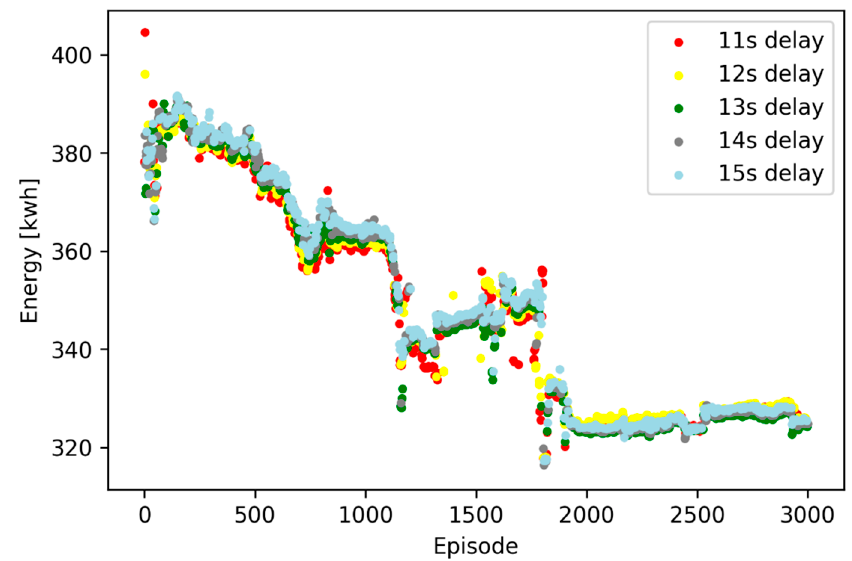
Figure 7. Energy consumption during training under discretely sampling random disturbances in the two-train network.